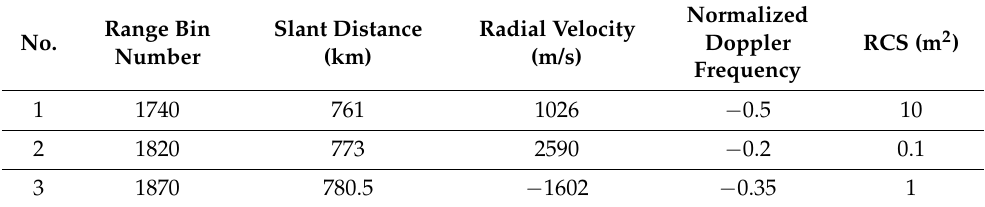
Table 2. Parameters of the moving target in the simulation